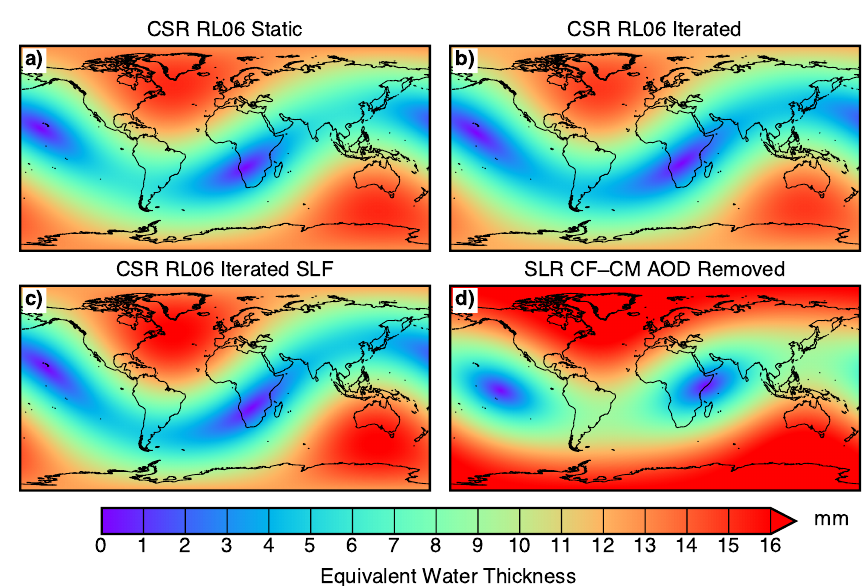
Figure 9. Annual amplitudes of measured and recovered degree one surface mass variations in mm water equivalent calculated from ( a – c ) time-variable gravity fields provided by the Center for Space Research, and ( d ) satellite laser ranging (SLR) CF-CM solutions. In the solutions derived from GRACE/GRACE-FO, the land-sea exchange is estimated using ( a ) a static seasonal geocenter from Chen et al. [7], ( b ) an iterated self-consistent geocenter, and ( c ) an iterated self-consistent geocenter taking into account the effects of self-attraction and